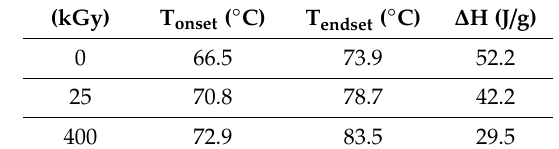
Table 2. Melting enthalpies and characteristic temperatures of ERP from differential scanning calorimetry (DSC) data. Table2. MeltingenthalpiesandcharacteristictemperaturesofERPfromdi ff erentialscanningcalorimetry (DSC) data.